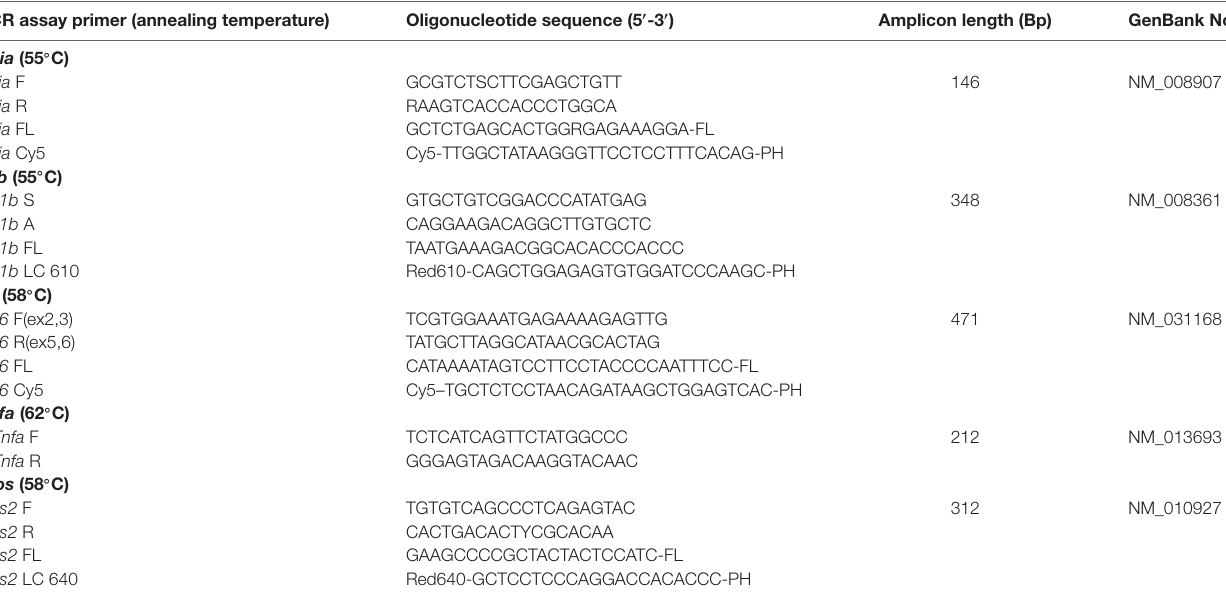
TABLE 2A | Primers and probes for quantitative real-time